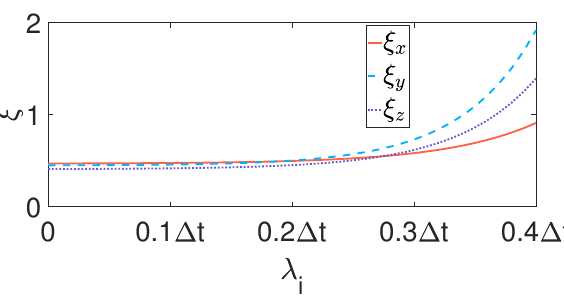
Figure 6. When the λ i takes different values, the convergence curve of ξ .